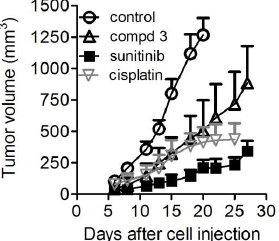
Figure 6. Antitumor activity of conjugate 3 in IGROV-1/Pt1 tumors. The effects of i.p. compound 3 , 20 mg/kg (having a sunitinib-equivalent loading 9 times lower than parental sunitinib), oral sunitinib, 40 mg / kg, qd × 5 / w × 4w and intravenous cisplatin (4.5 mg / Kg, q7d × 3) were evaluated on the growth of the IGROV-1 / Pt1 carcinoma cells s.c. injected into the right flank of female nude mice (10 7 cells / mouse) on day 0. Treatment started on day 4: compound 3 (open up triangle), sunitinib (filled square), cisplatin (down triangle) or control (open circle). Experimental groups consisted of seven animals. Growth curves of the tumors are shown. Points report mean values of tumor volumes. Bars: